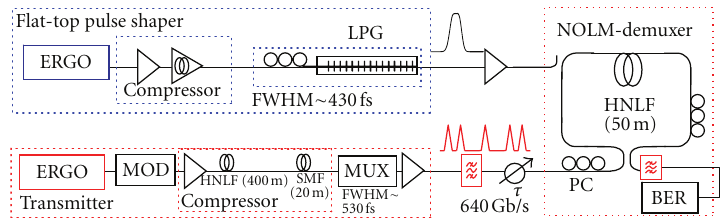
Figure 9: Setup for 640 Gbit/s. ERGO—erbium glass oscillator, PC—polarization controller, MOD—modulator, BER—bit error